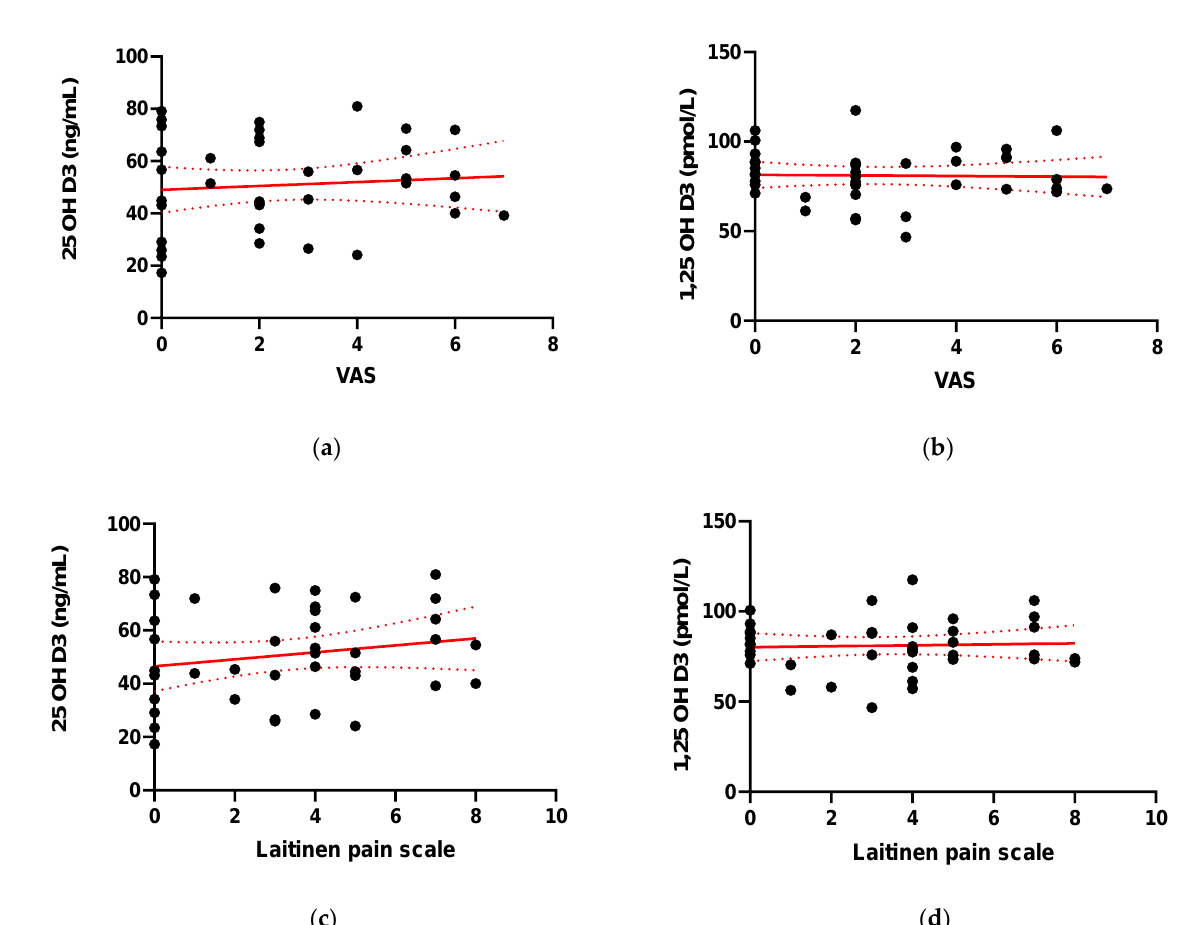
Figure 6. Correlation between serum concentration of 25-hydroxy Vitamin D (25(OH) Vitamin D) ( a ) and 1,25-hydroxy Vitamin D (1,25(OH)2 Vitamin D) ( b ) and the value of the visual analog scale (VAS) for quantification of disease-related pain ( c ); and the value of the modified Laitinen Pain Scale (c and d respectively) in IBD patients ( d ).